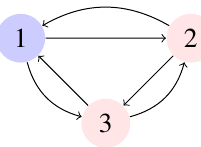
Fig. 4. An example of balanced coloring in CCN.